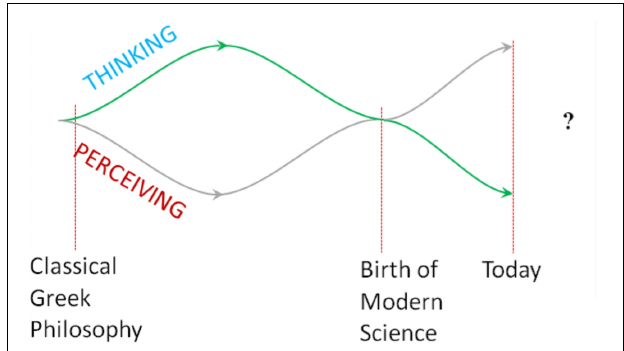
FIGURE 2 | Divergence and confluence of thinking and